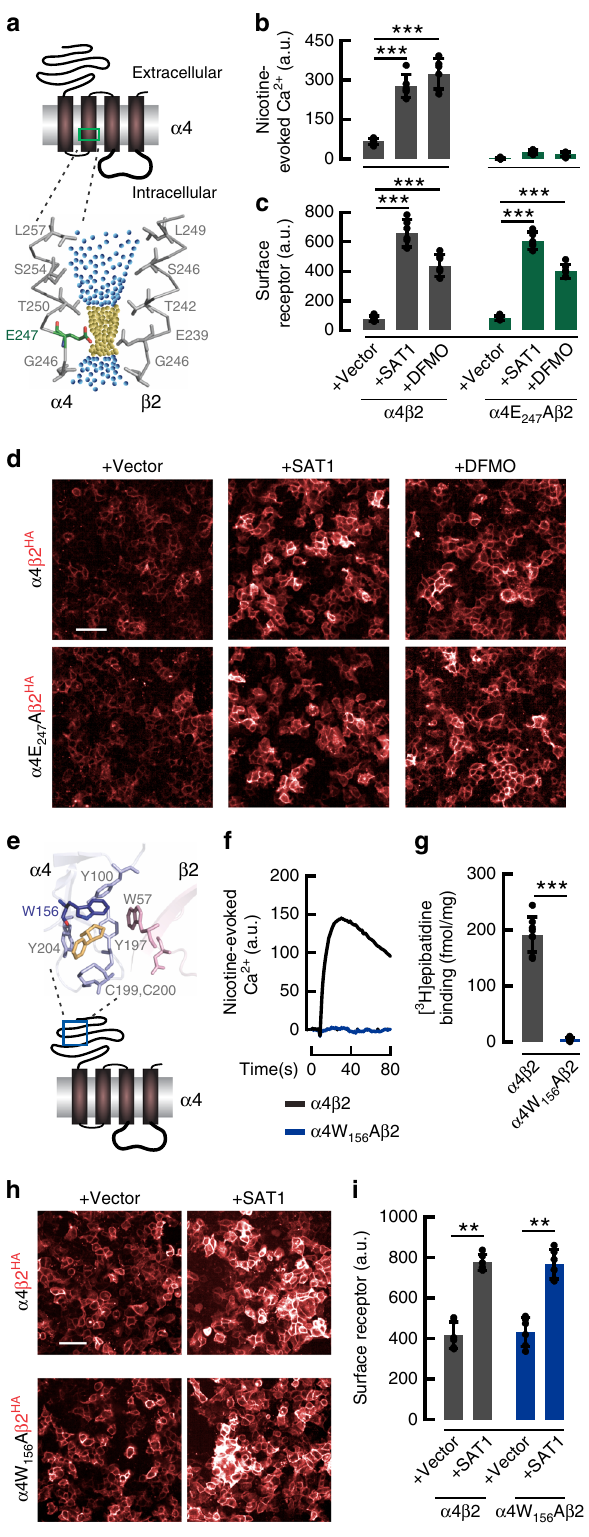
We next evaluated effects of BenSpm and PhTx-343 on the α 6/ α 4 chimeric constructs, which swap the extracellular N-terminal or TM3-TM4 cytosolic loop domains. As predicted, the α 4 cytosolic loop was necessary and suf fi cient for BenSpm pre-treatment to